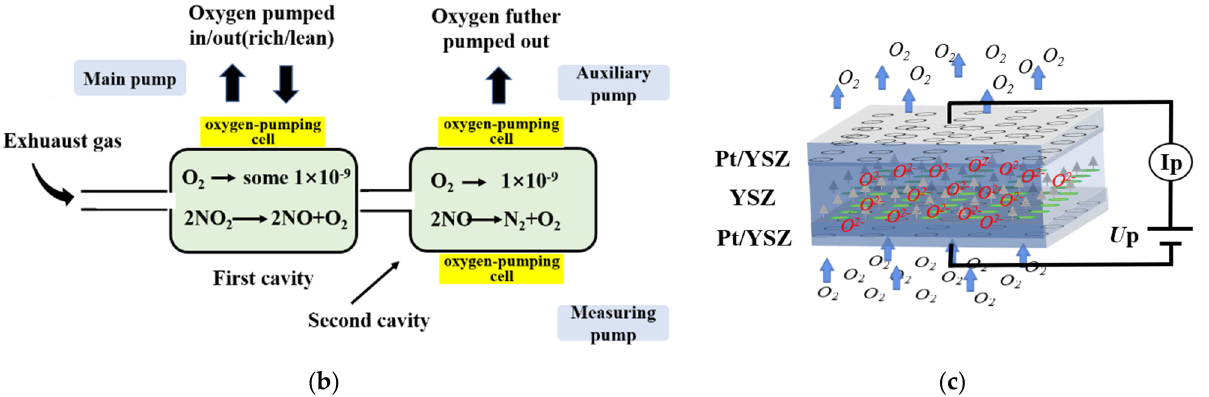
Figure 1. ( a ) Structure of the current type NO x sensor; ( b ) NO x concentration detection principle; ( c ) (Pt/YSZ)/YSZ sensor unit oxygen pumping principle.